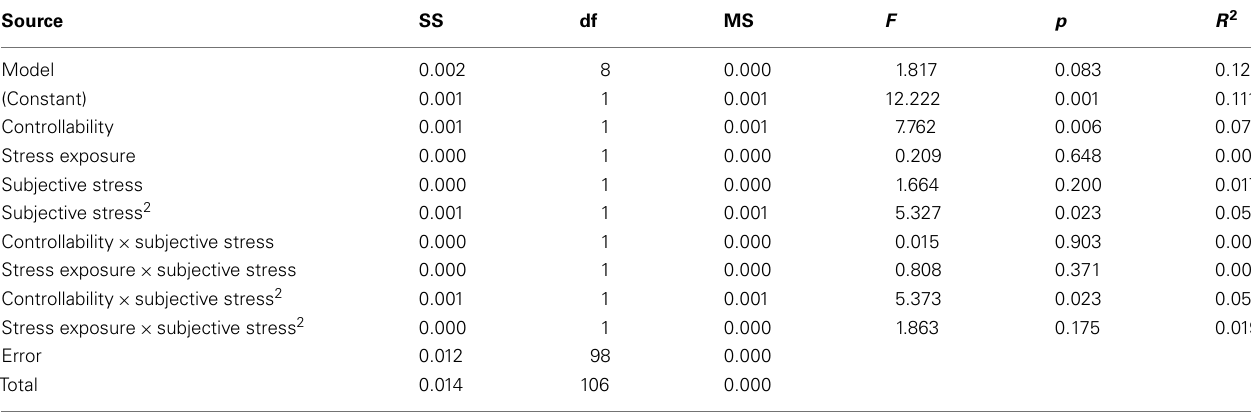
Table 3 | Regression table for Experiment 1, model predicting change in Stroop interference (post-pre stress manipulation) by group status (controllability: compares CSt versus USt groups; stress exposure: compares NSt group versus the average across CSt and USt groups); subjective stress response (subjective stress: the linear effect of subjective stress; subjective stress 2 : the quadratic effect of subjective stress); and interactions between these